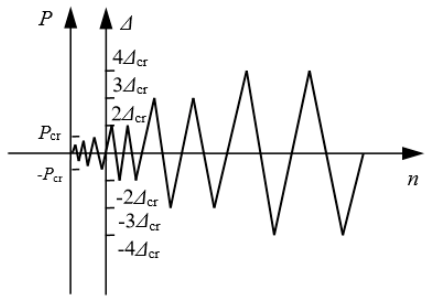
Figure 3. Horizontal loading program of pseudo-static test.